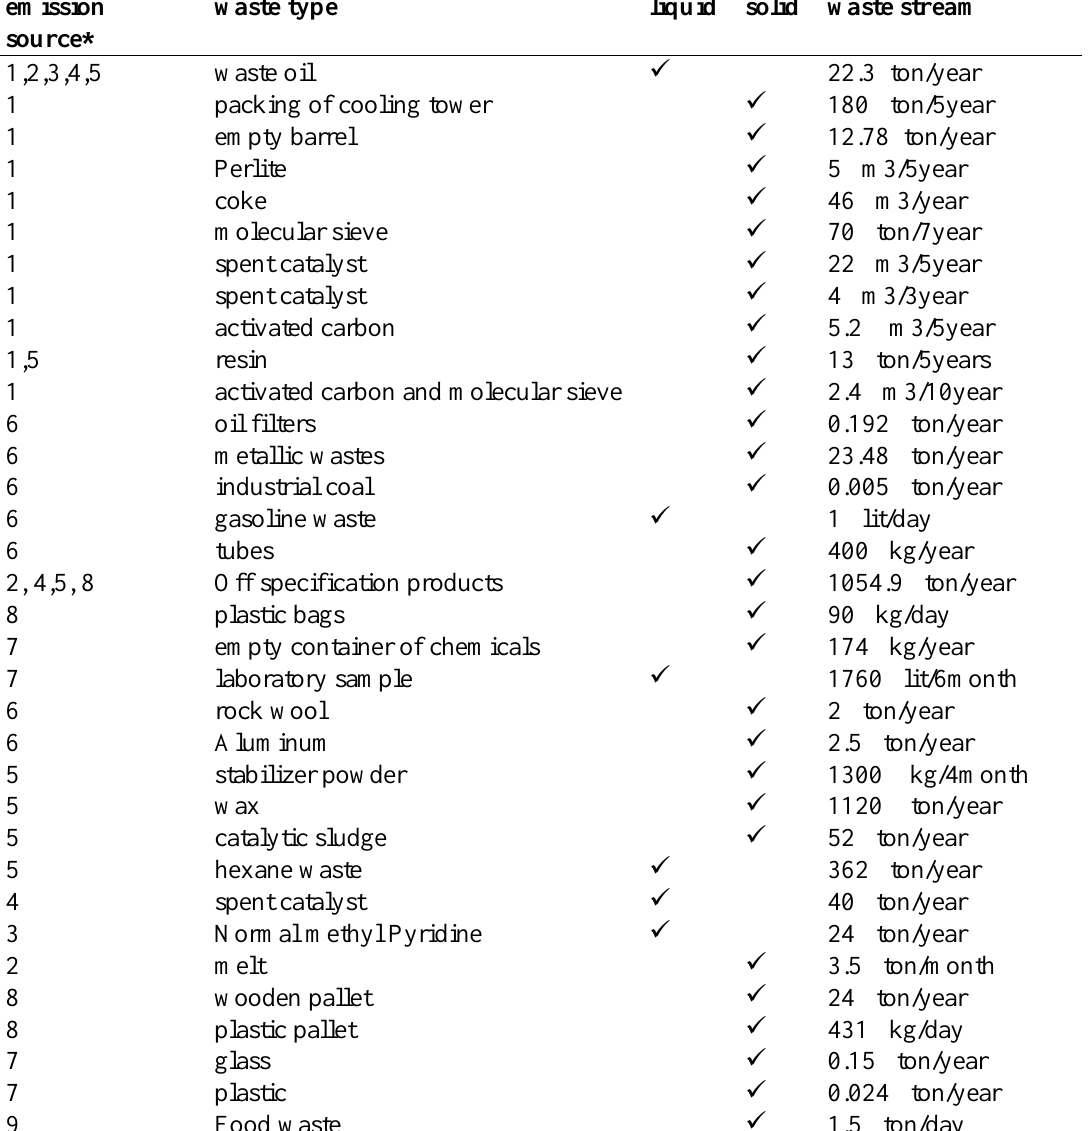
Table 1: Wastes generated at Amirkabir petrochemical complex